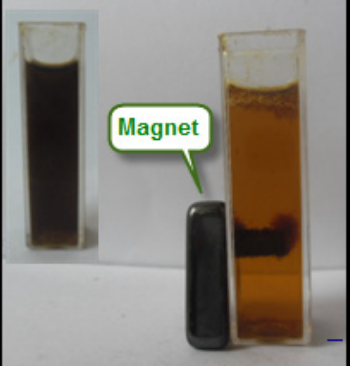
O -NPs from BS extract under an external magnetic 3 4